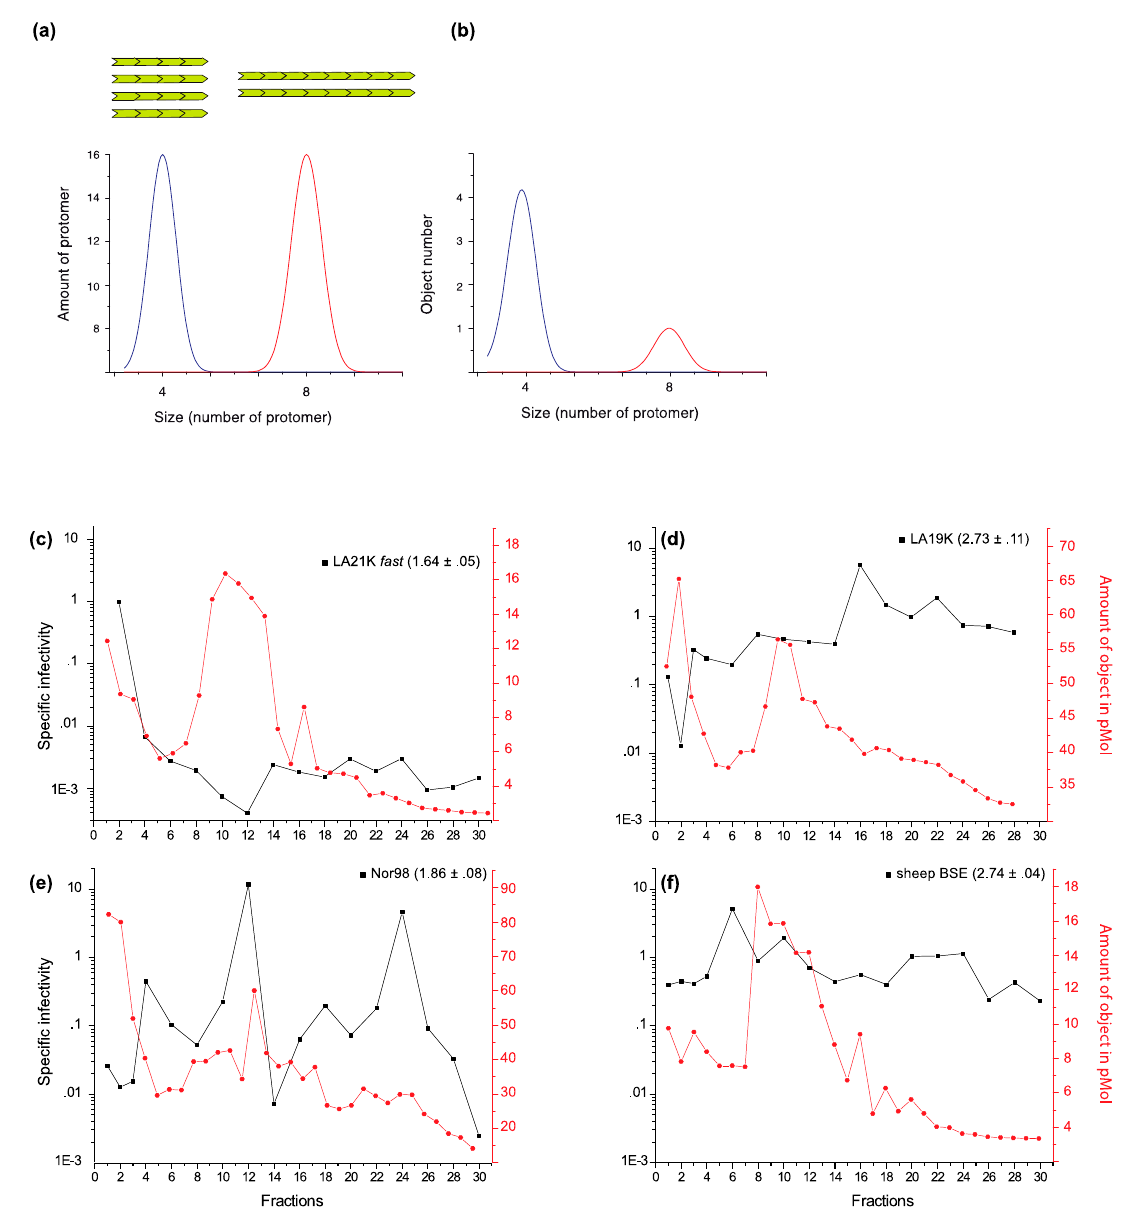
Figure 1. Size distribution of PrP Sc assemblies and of their specific infectivity among di ff erent ovine prion strains. ( a , b ) Illustration describing the SV profile of two sets of assemblies (A and B) equivalent to the total number of protomers but di ff erent in terms of size. The sedimentogram is expressed as a function of protomer amount ( a ) or object number ( b ). The object number is also representative for the templating interfaces by assuming that templating can occur at least by one of the extremities. ( c – f ) SV profiles of ovine prion strains (original data from [25]). The specific infectivity of the SV-fractionated assemblies (black line) was calculated by dividing the relative infectivity of the assayed fraction by the relative amount of protease-resistant PrP Sc . The relative infectivity values were obtained from survival time bioassays in reporter tg338 mice. Specific infectivity values of ( c ) LA21K fast scrapie strain classified as fast strain (mean survival times of 56 days in tg338 mice), ( d ) LA19K (133 days), ( e ) Nor98 (186 days) and ( f ) sheep BSE (135 days), as slow strains. The amount of PrP Sc assemblies in terms of object (red line) has been estimated by dividing the sedimentogram expressed in the equivalent of monomeric PrP by the theoretical fraction-molecular weight correspondence after calibration of the gradient for molecular weight [25]. The guanidine hydrochloride denaturation values of each strain are indicated ([Gdn] 1 / 2 values in mol / L ± SEM, data from